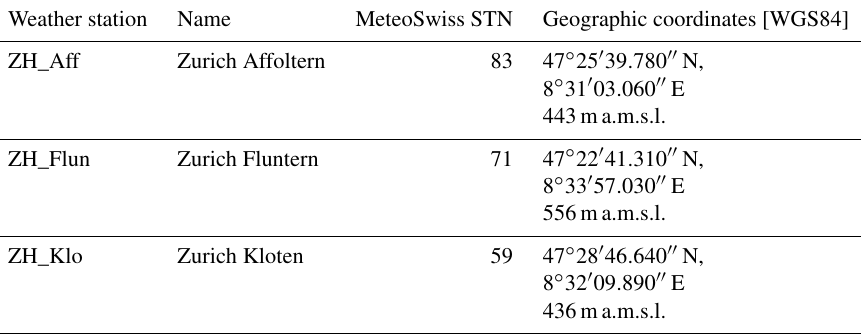
Table 2. Location of the MeteoSwiss weather